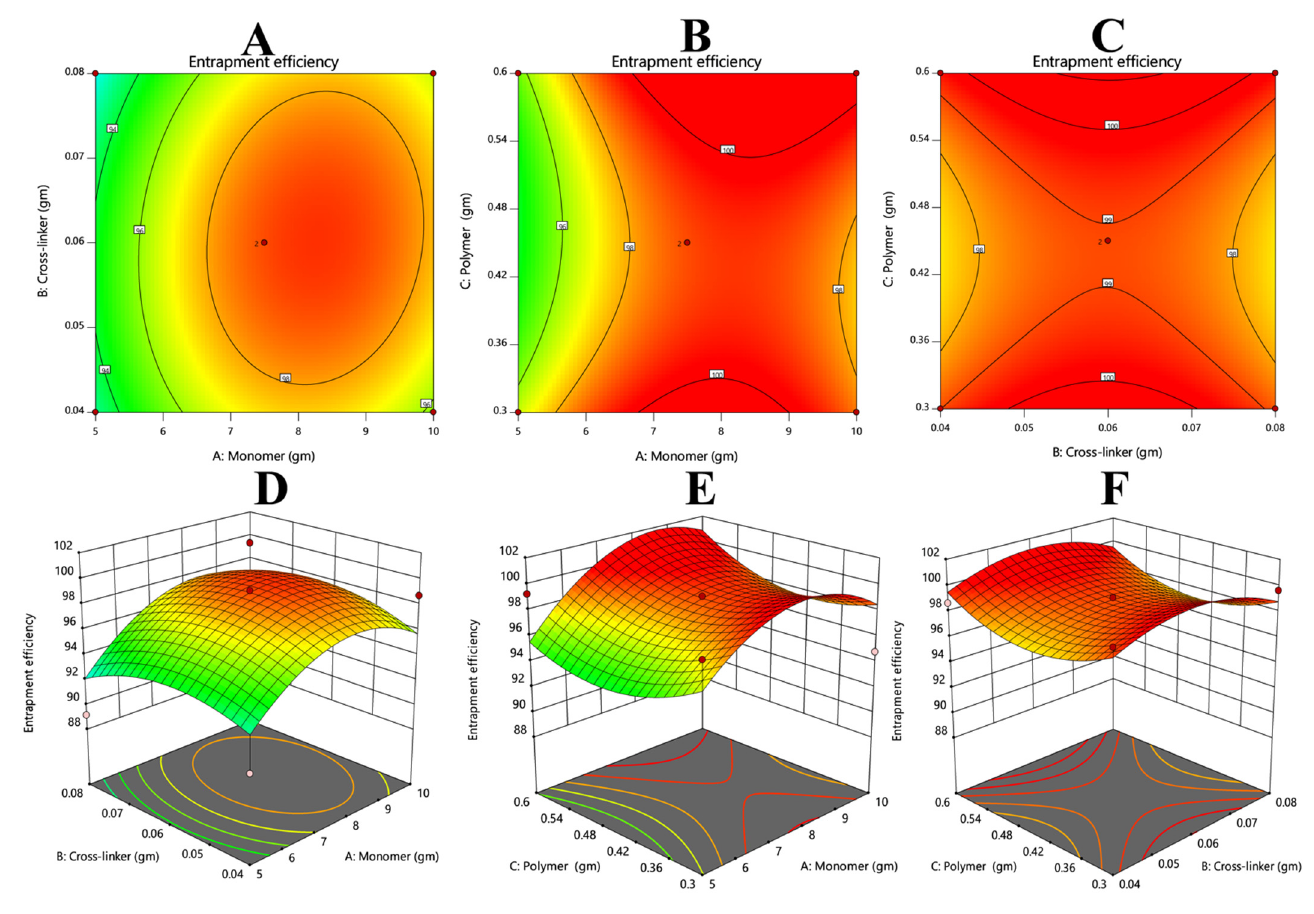
Figure 7. Describing the relationship between entrapment efficacy and the variable concentrations of crosslinker, monomer, and polymer. ( A , D ), ( B , E ), and ( C , F ) describe that the drug entrapment efficiency would be improved with increases in concentrations of monomer and polymer, but an increase in the concentration of crosslinker could be the cause of a decrease in the drug entrap- ment.